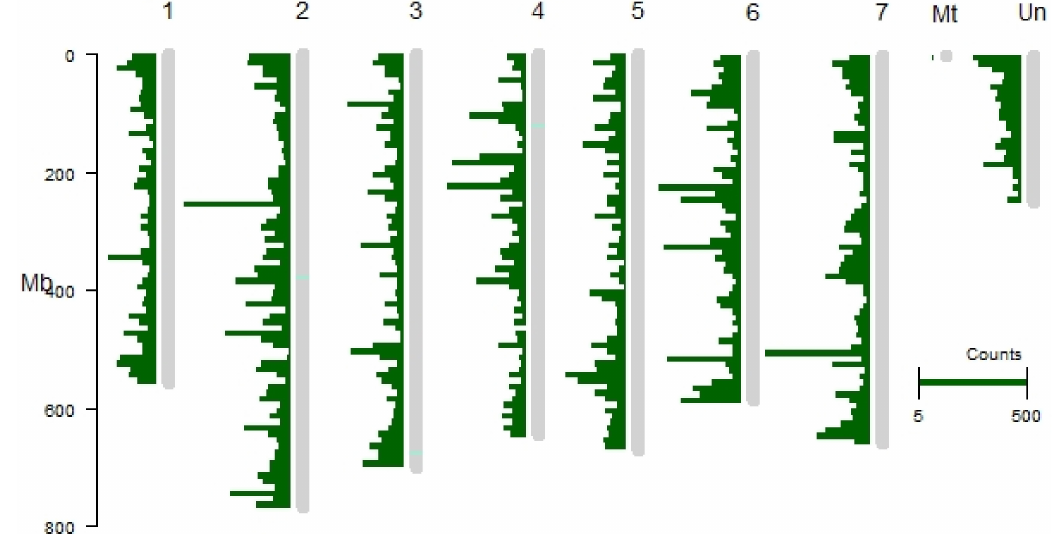
Figure 2. Distribution of lncRNA isoforms on barley chromosomes. Length of horizontal bars corresponds to the mapped read counts.